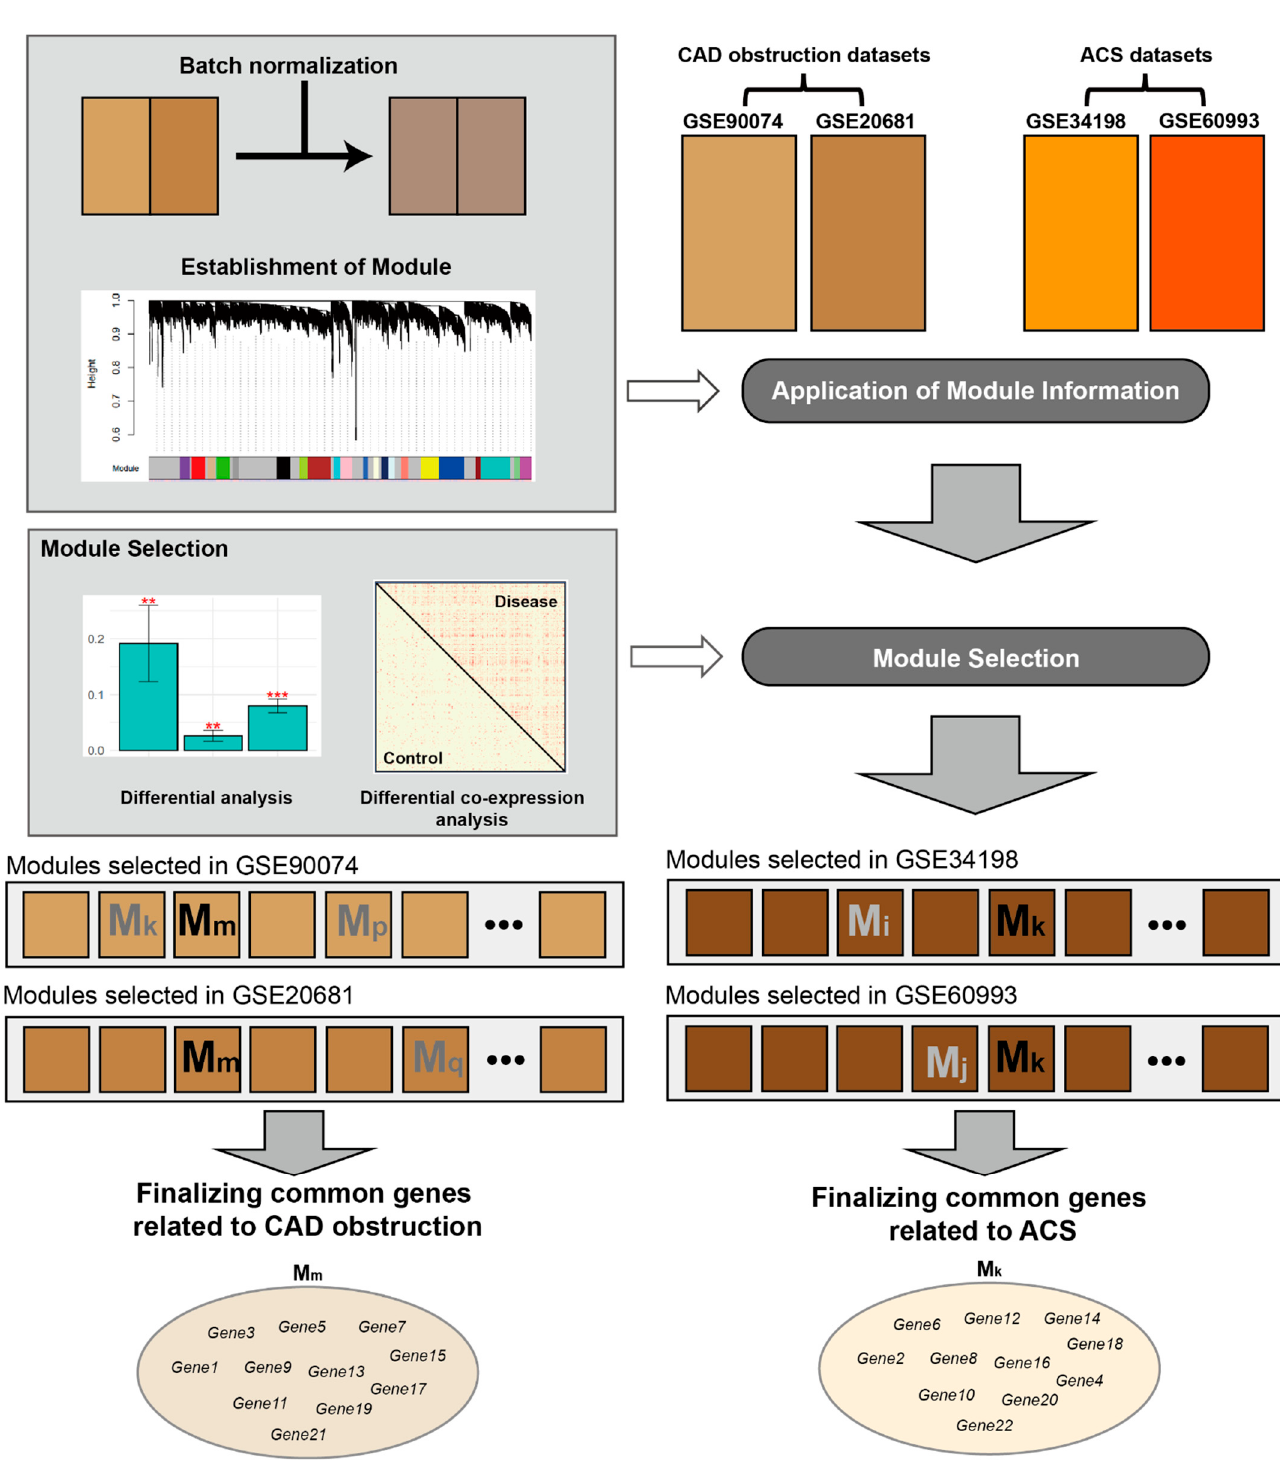
Figure 1. Flow diagram of this study for identifying cardiovascular disease-related modules and genes. GSE90074, GSE20681, GSE34198, and GSE60993 are blood transcriptomic datasets obtained from Gene Expression Omnibus database [19]. Abbreviations: CAD, coronary artery disease; ACS, acute coronary syndrome; GSE, gene expression data series. ** p < 0.01, *** p <